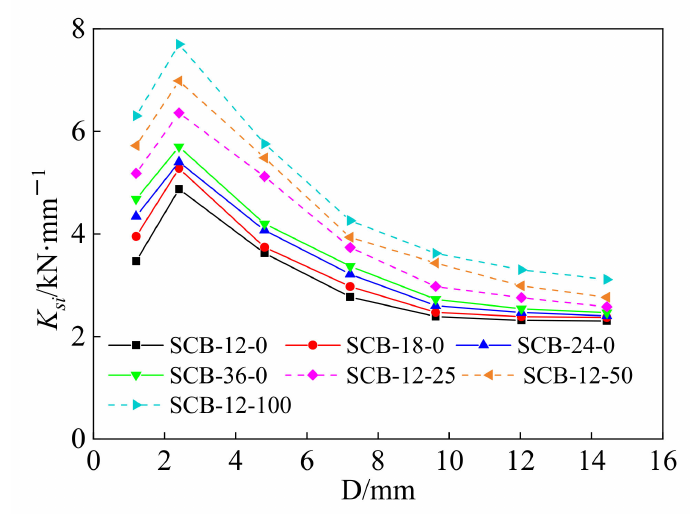
Figure 9. Secant stiffness of self-centering SMA brace specimens.